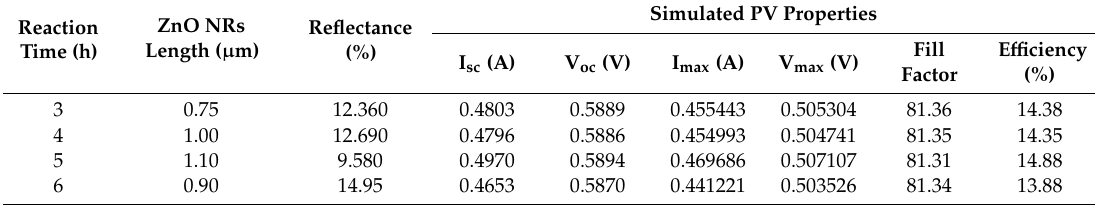
Table 2. Summary of optical and PV properties of ZnO NRs AR-based Si solar cells (PC1D simulation). Reaction Time